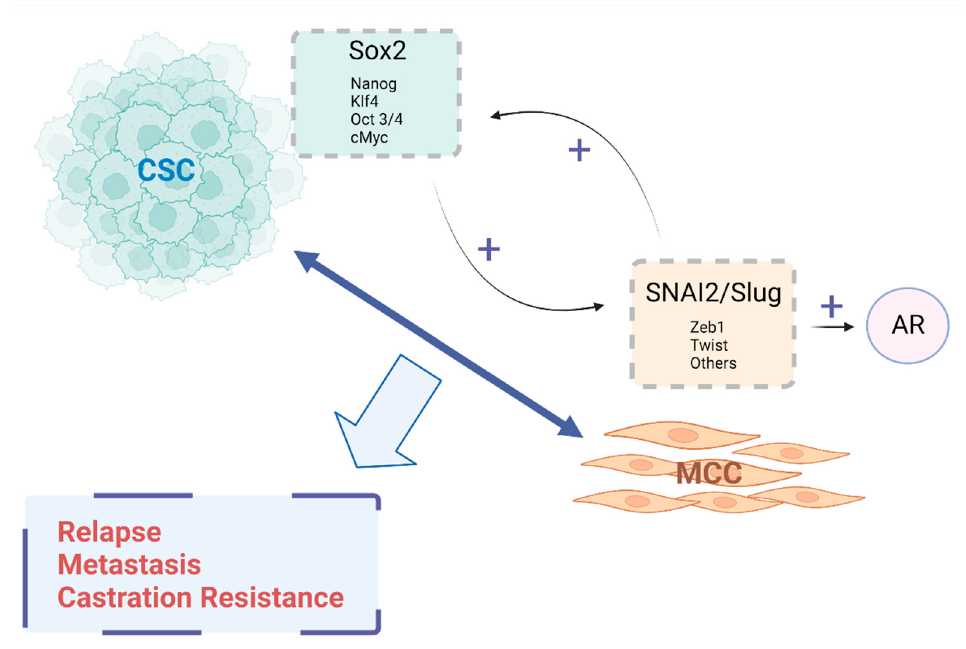
Figure 2. Proposed model for stemness–EMT axis in prostate cancer. CSC: cancer stem-like cell; MCC: Mesenchymal-like cancer cell; AR: Androgen Receptor.